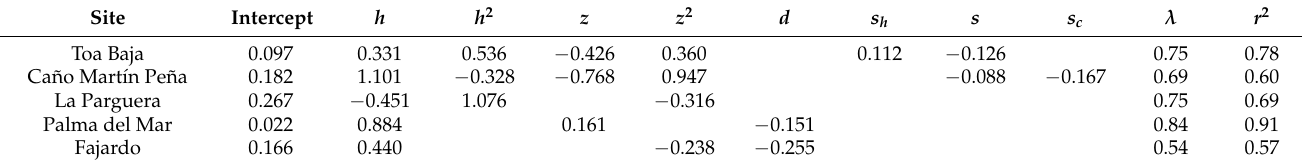
Table 4. Spatial regression of normalized canopy height reduction ( ∆ h ) on normalized covariates: h , pre-hurricane canopy height; z , elevation; d , algorithm-derived tree density; s h , standard devi- ation of pre-hurricane canopy height; s , distance to rivers/canals; s c , distance to coast; λ , spatial autocorrelation coefficient; r 2 , coefficient of determination. All coefficients were significant at α = 0.05.